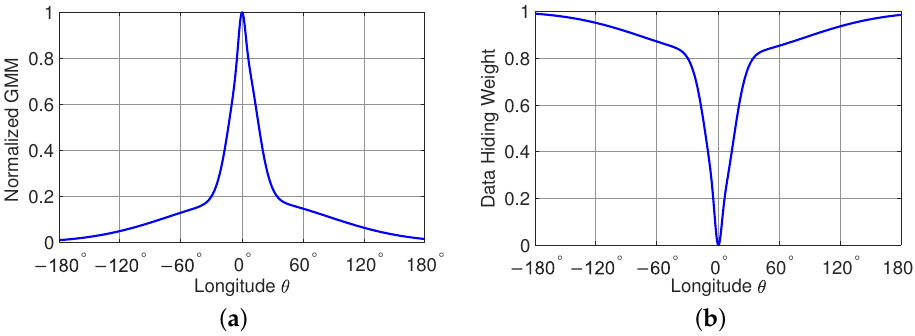
Figure 10. Normalized GMM for the longitude: ( a ) Normalized relative viewing direction frequency ˆ g ( θ ) , ( b ) Data hiding weight function w 2 ( θ ) .